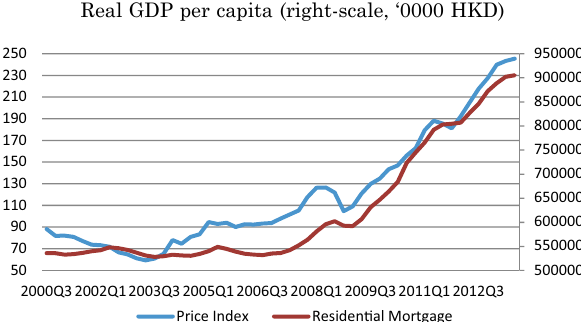
fig. 4. trends comparison among Property Price Index and other potential factors Source : Hong Kong Monthly Digest of Statistics, by census and Statistics Department in